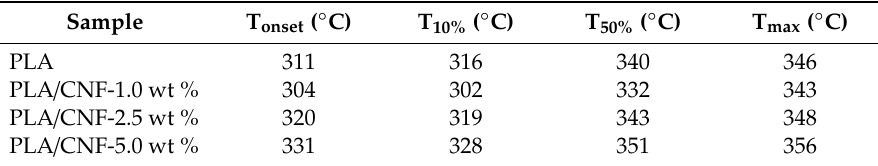
Figure 7. TGA ( a ) and DTG ( b ) graphs of PLA / CNF biocomposite films. Table 1. TGA thermal characteristics of PLA and PLA / CNF biocomposite films.